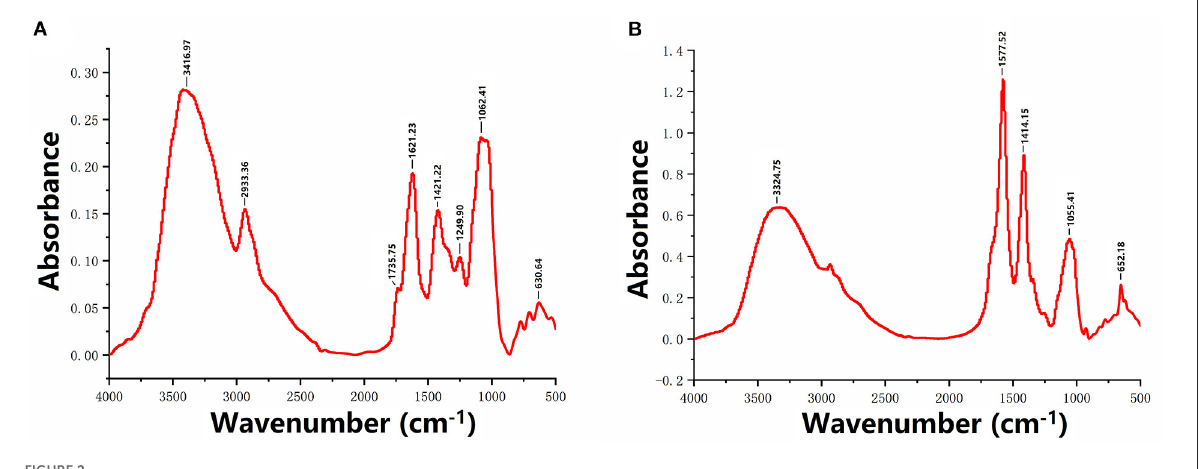
FIGURE2 FT-IR analyses of SDF (A) and IDF (B) .